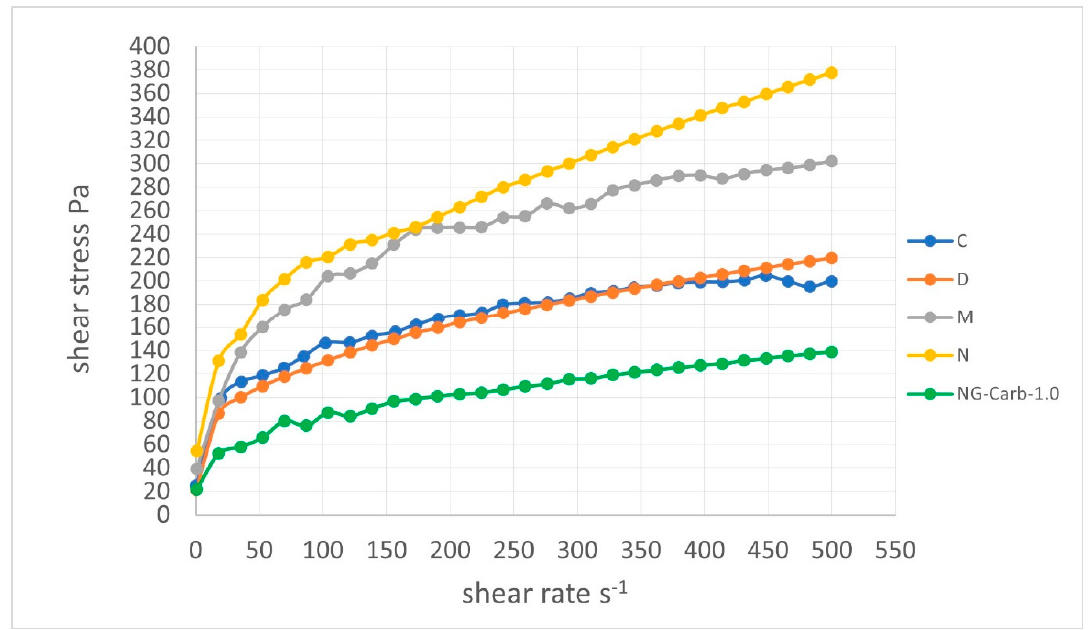
Figure 3. Flow curves of samples belonging to a physicochemical form group–ointments.